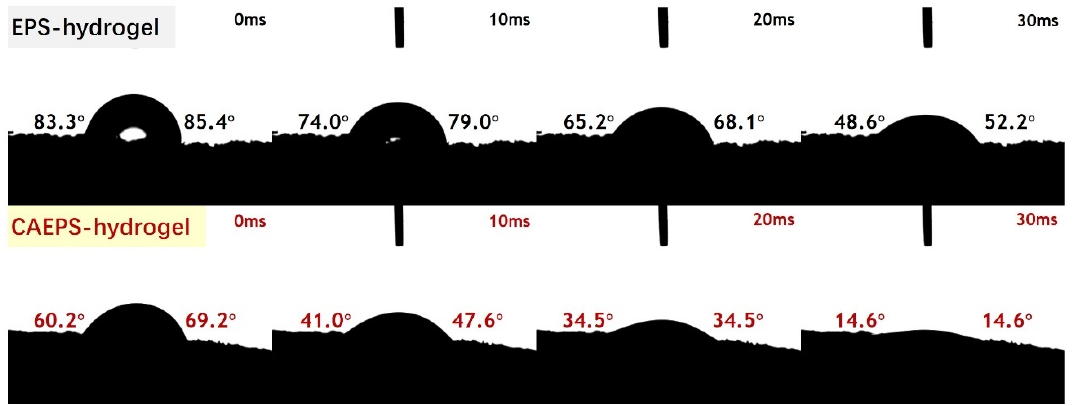
Figure 7. The water droplet on EPS- and CAEPS-hydrogel and the WCA of EPS- and CAEPS-hydrogel, respectively. Note: The water droplet is 2 µL.